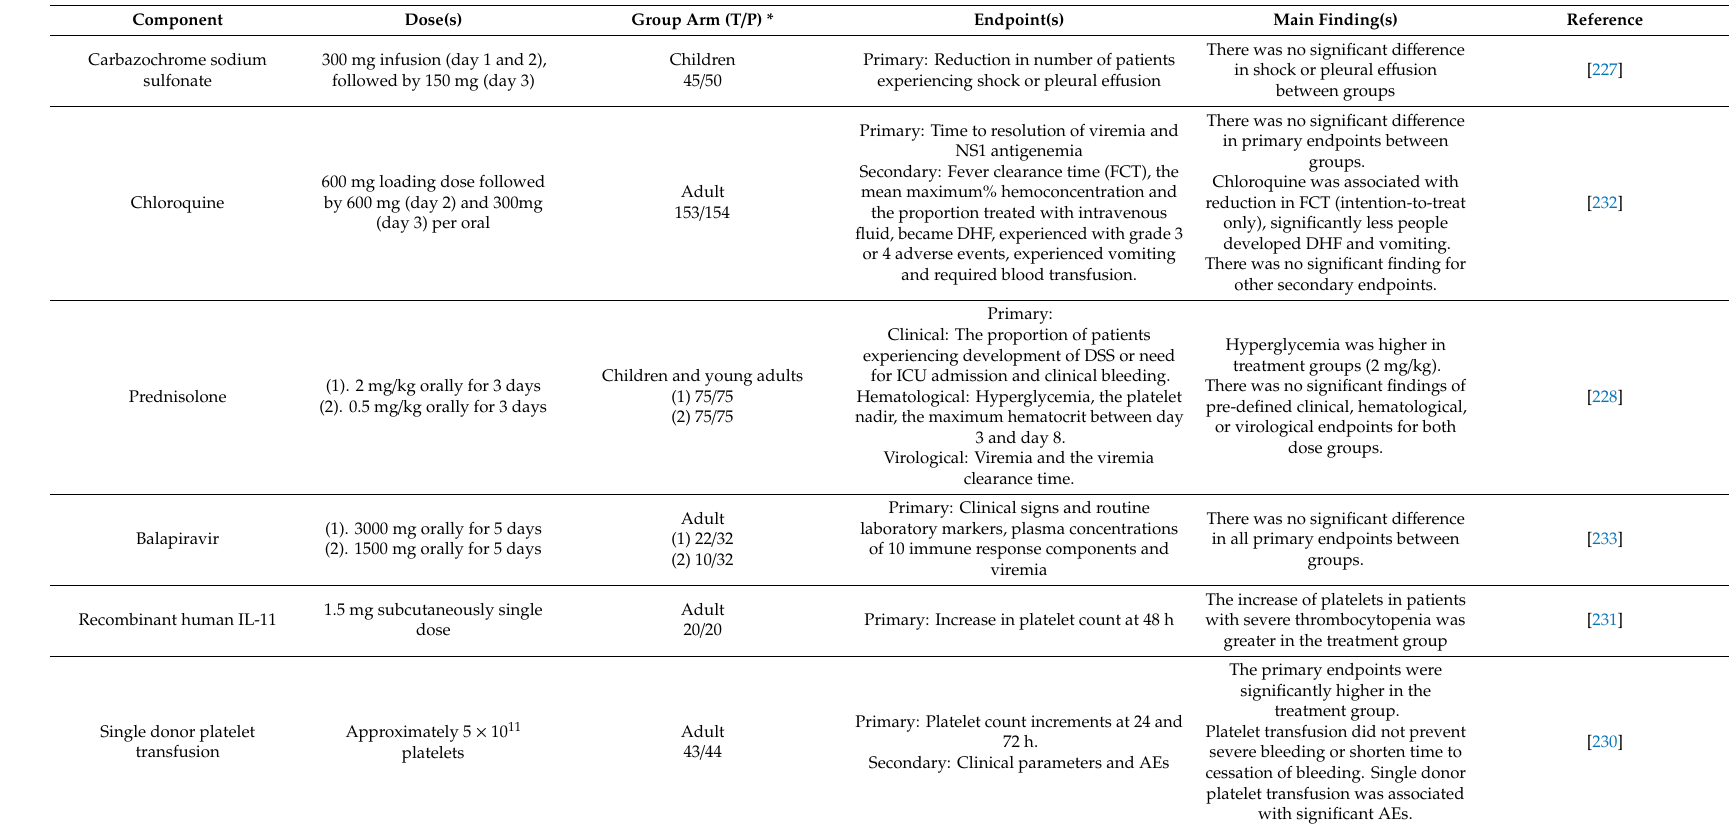
Table 6. Summary of trial studies on dengue